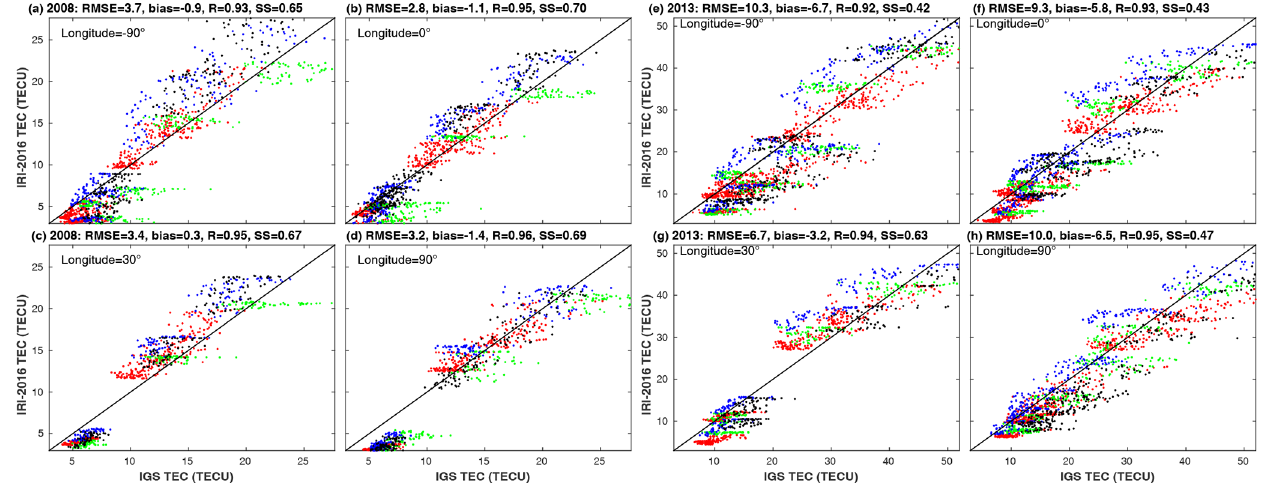
Figure 5. Scatter plots of TECs from IRI-2016 and GPS at selected longitudes for the solar minimum in 2008 (a–d) and the solar maximum in 2013 (e–h) for the morning hours’ measurements and simulations. The data are colored according to season: March equinox (green), June solstice (red), September equinox (blue), and December solstice (black). The RMSE, bias, R , and skill score (SS) indicated at the top of each panel are calculated for the whole data set (all seasons and all observation times) within the ± 20 ◦ geomagnetic latitude